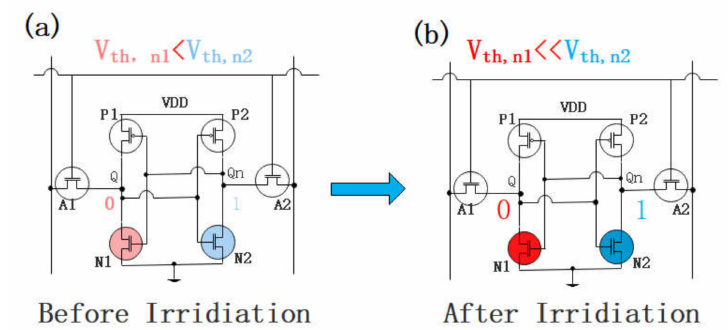
Figure 4. ( a ) Weak cell before irradiation and ( b ) weak cell after irradiation. If a weak cell outputs unstable logic ‘0’ before irradiation, it will output stable logic ‘0’ after